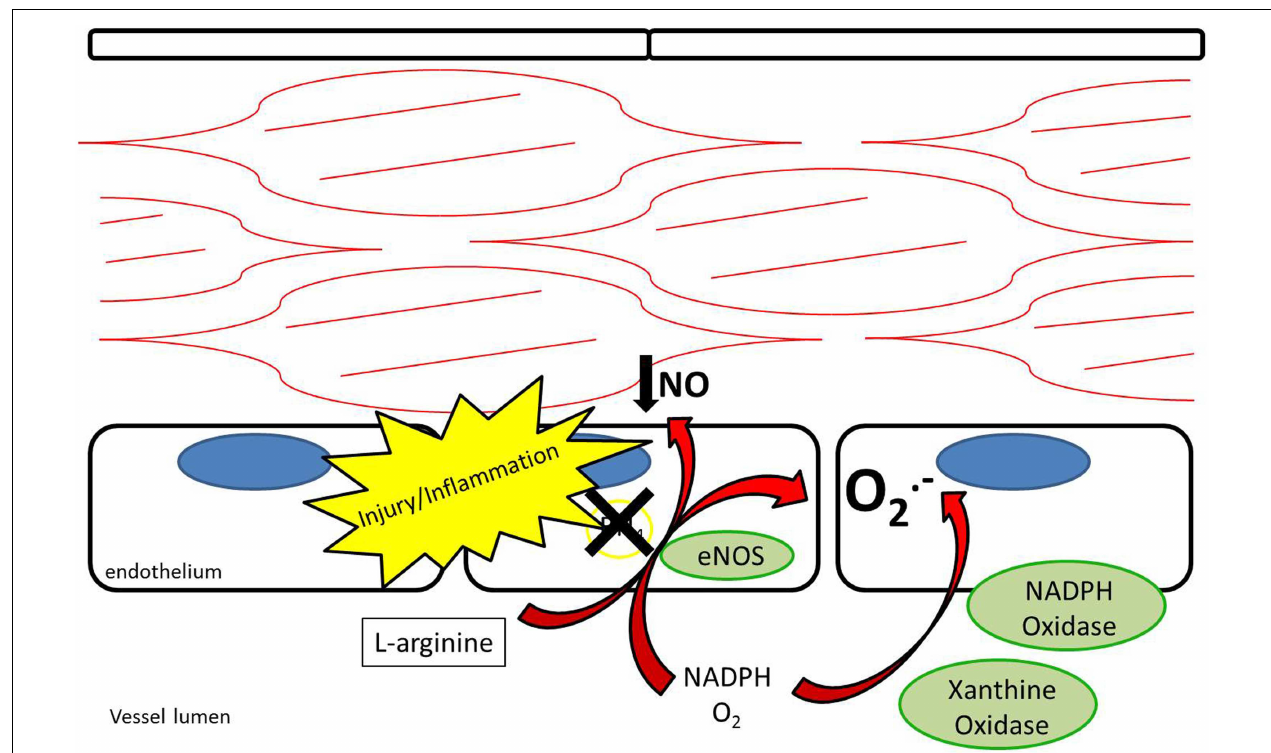
FIGURE 3 | Endothelial nitric oxide synthase uncoupling results in reduced production of nitric oxide as well as production of superoxide anions . NADPH oxidase and xanthine oxidase also contribute to production of superoxide